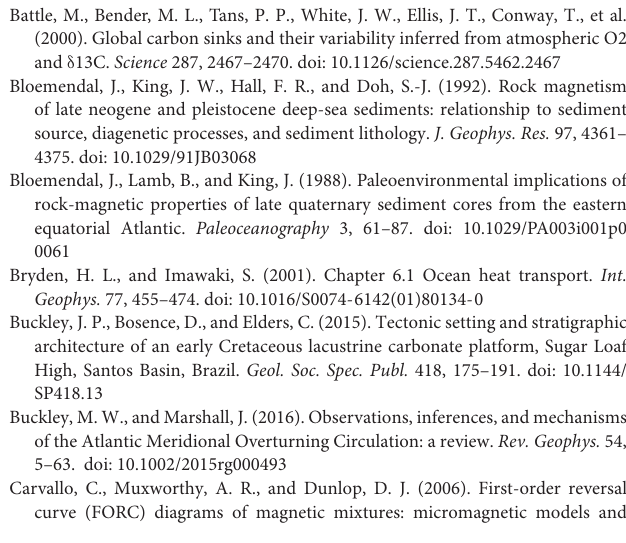
FIGURE S1 | Supplementary paleomagnetic results. Inclination unflattening for samples from the first quality group